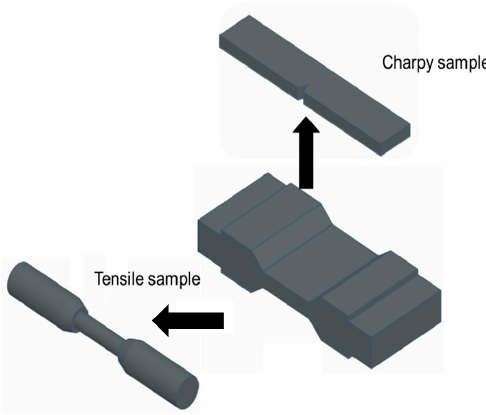
Figure 2. Schematics of the mechanical property sample extraction from the plane strain compression